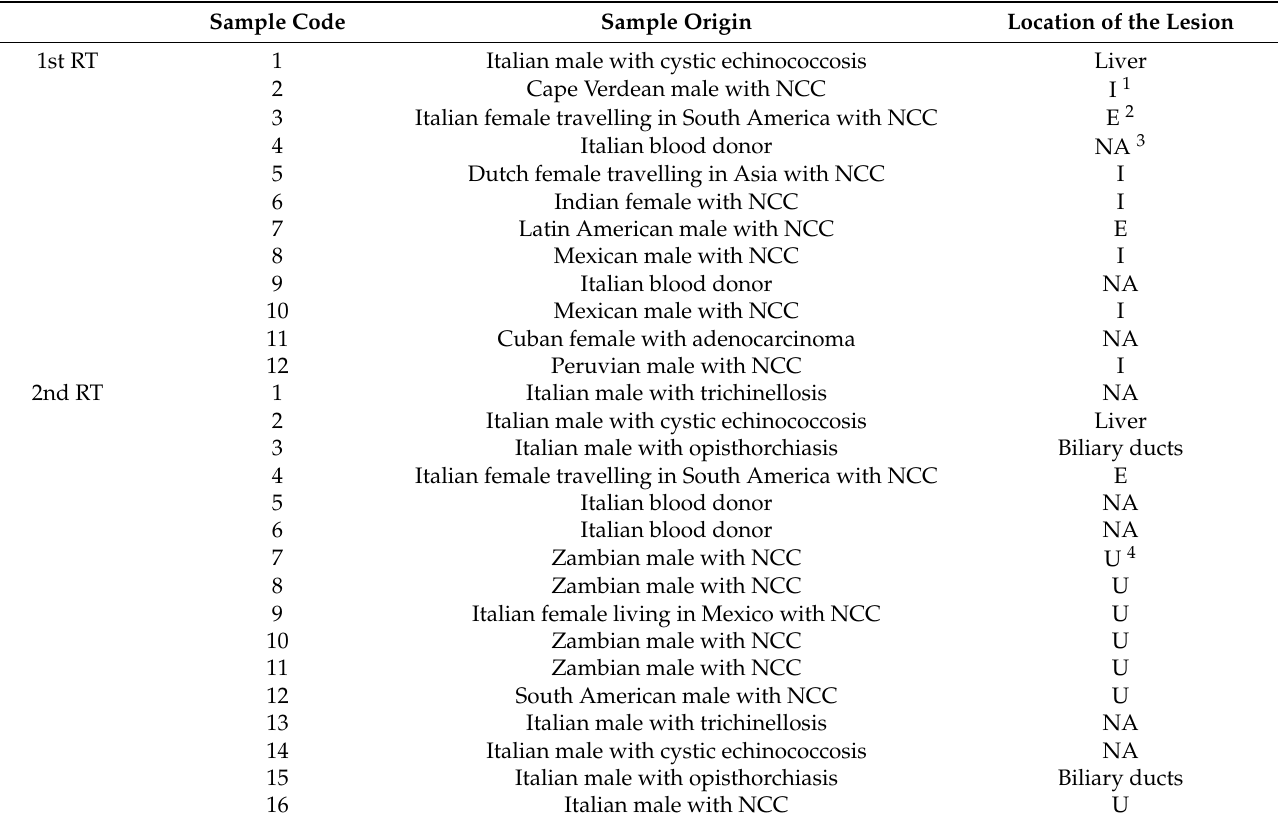
Table 2. Panels of human serum samples provided for the Ring Trials